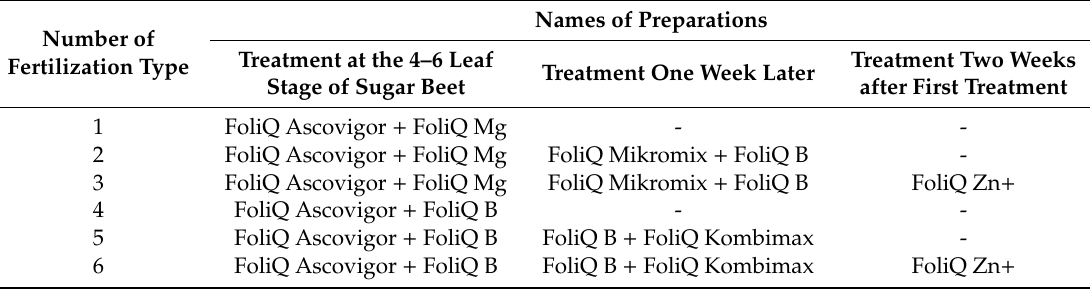
Table 6. Types of foliar fertilization for sugar beet tested in the